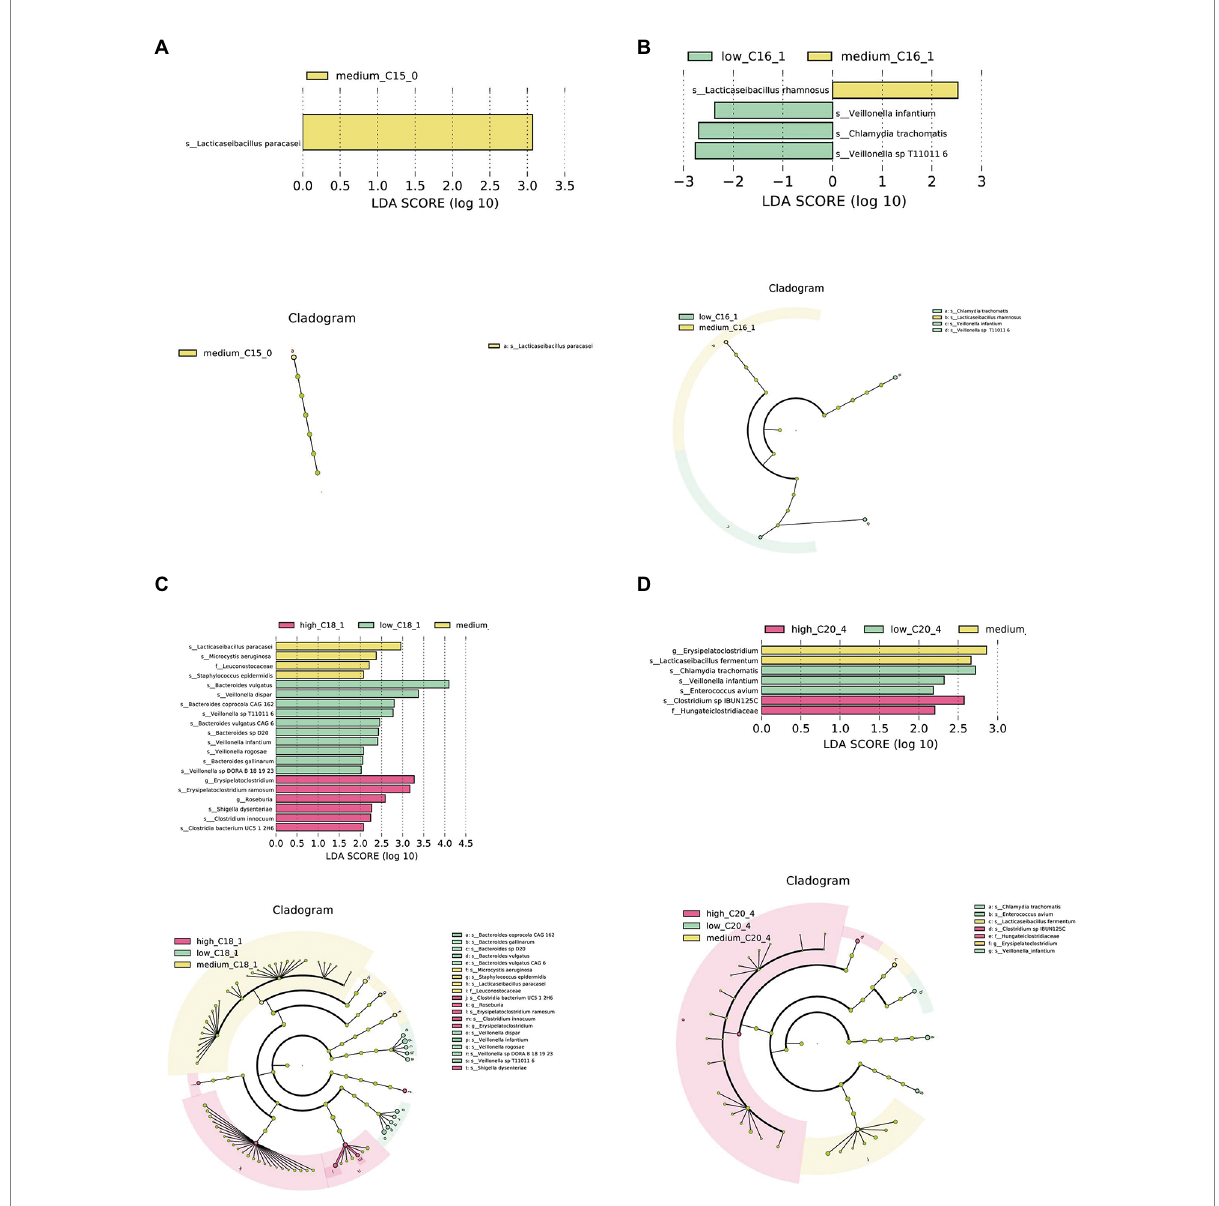
FIGURE 2 Biomarkers of differences between different FA content groups in human milk. (A–D) LEfSe analysis of C15:0, C16:1, C18:1, and C20:4 groups, respectively. Taxonomic cladogram obtained from LEfSe and linear discriminant analysis (LDA) of these groups. Biomarker taxa are highlighted with colored circles and shaded areas. Each circle’s diameter reflects the abundance of those taxa in the community, using a cutoff value of ≥